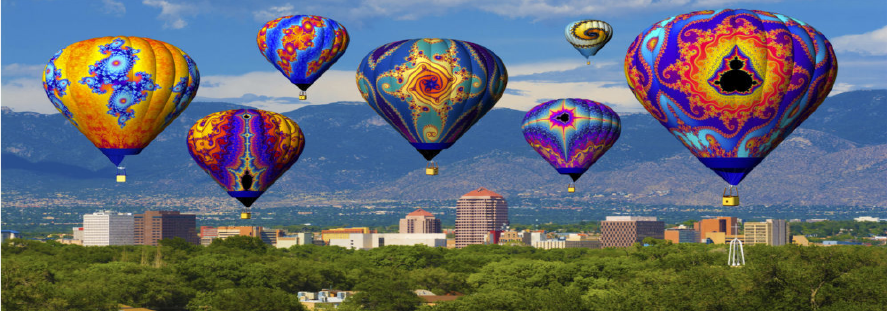
Figure 30. Fractal balloons flying over Albuquerque (Fractal Capital of the World) and home of Fractal Balloons, Image source: Fractal foundation, available from https://fractalfoundation.org/ (accessed on 20 October